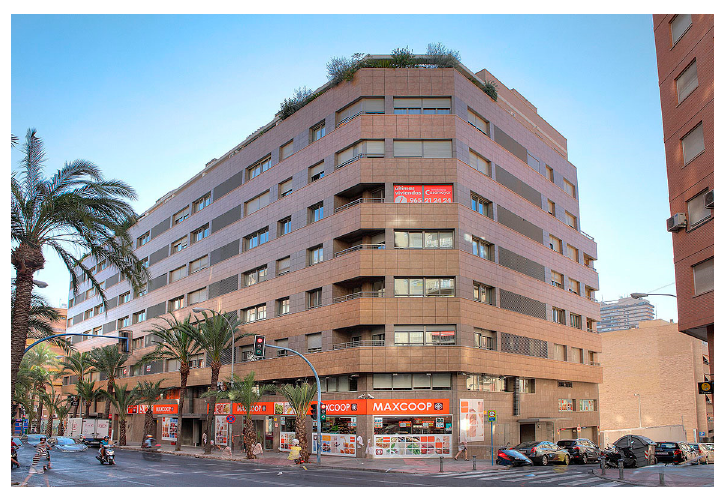
Figure 3. Building façade. North façade and west façade.